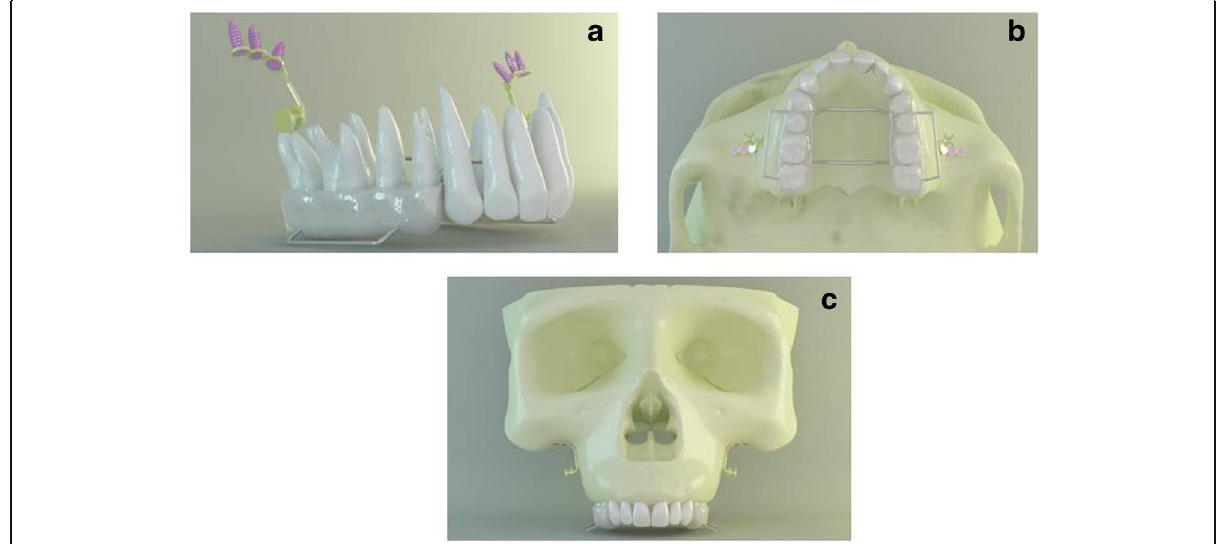
Fig. 1 a View of the acrylic appliance and the anchorage unit. b Occlusal view of the appliance. c First scenario with no